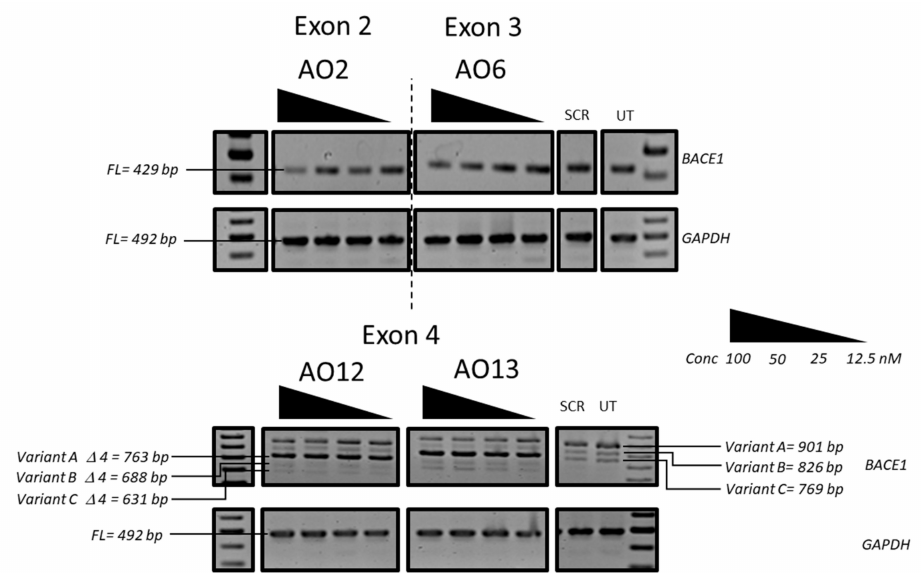
Figure 3. RT-PCR analysis of the BACE1 and GAPDH transcripts after treatment with the best working 2’-O-MePS AOs (AO2, AO6, AO12, and AO13) targeting exons 2, 3, and 4 at 100 nM, 50 nM, 25 nM, and 12.5 nM concentrations in HEK293 cells. FL, full-length; UT, untreated; SCR, scrambled sequence; GAPDH was used as a loading control. The gel images were cropped to highlight the BACE1 specific products and the corresponding house-keeping gene control GAPDH . The original images are shown in Figure S4 (Supplementary